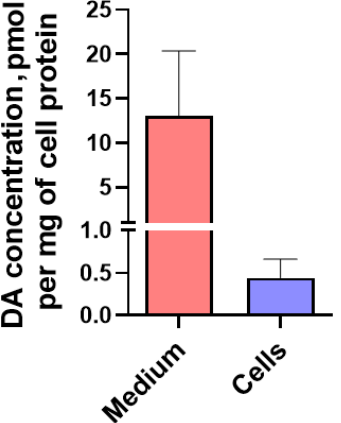
Figure 5. Dopamine (DA) content normalized to cell protein in LUHMES cells and incubation medium (artificial cerebrospinal fluid) containing pargyline (30 µM), tolcapone (10 µM), and L-DOPA (100 nM).